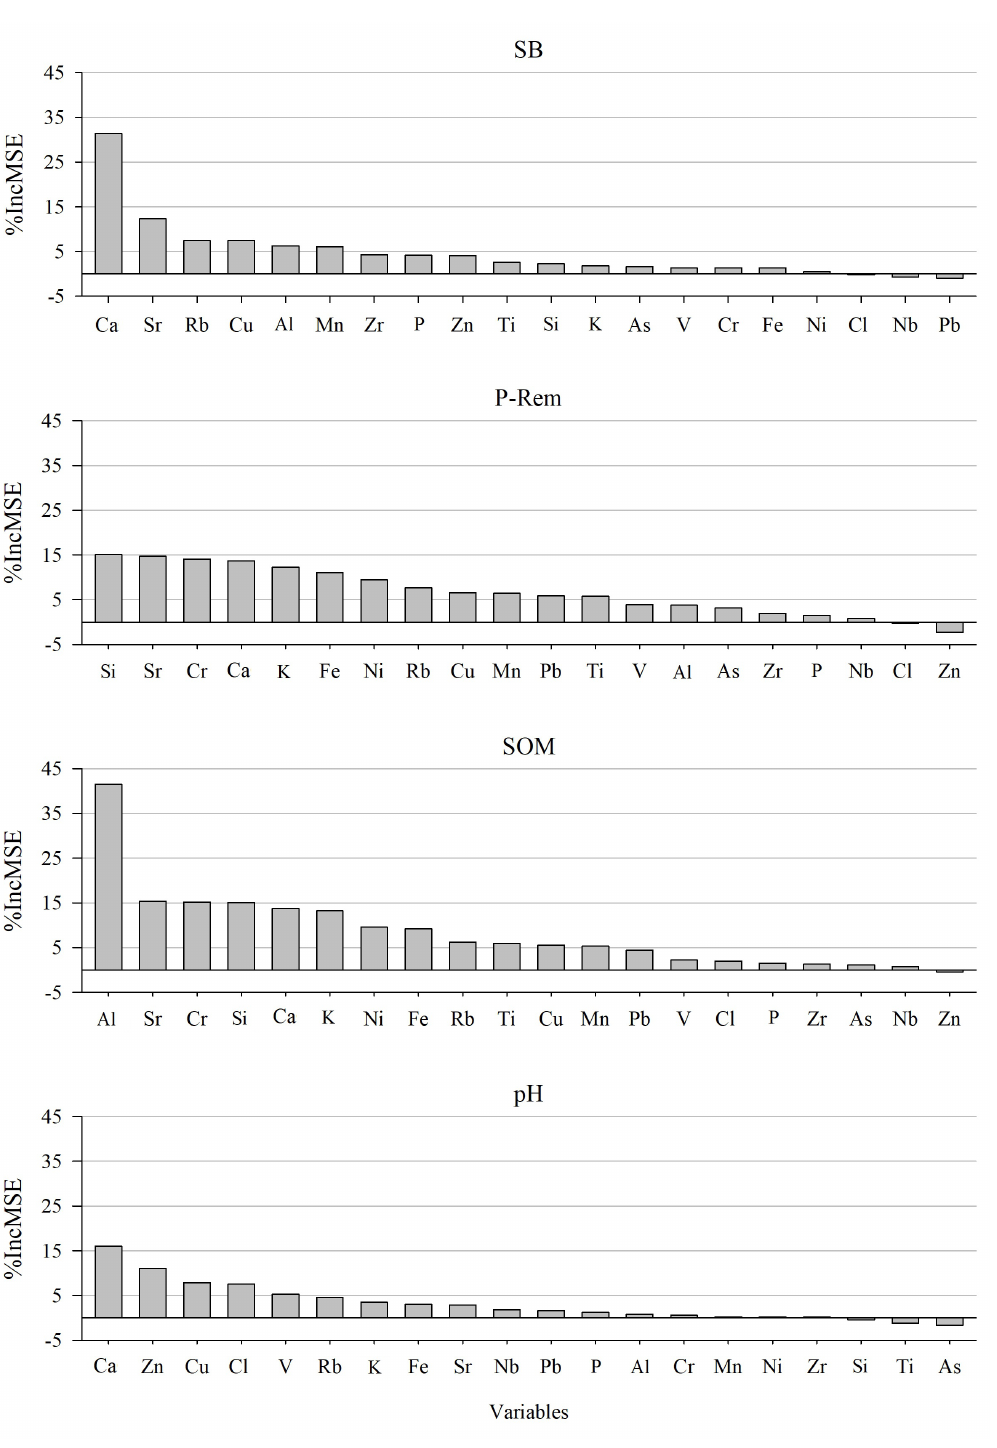
Figure 4. Most important variables for sum of bases (SB), remaining P (P-Rem), soil organic matter (SOM) and pH predictions via Random Forest from data of samples collected at Lavras, Minas Gerais,